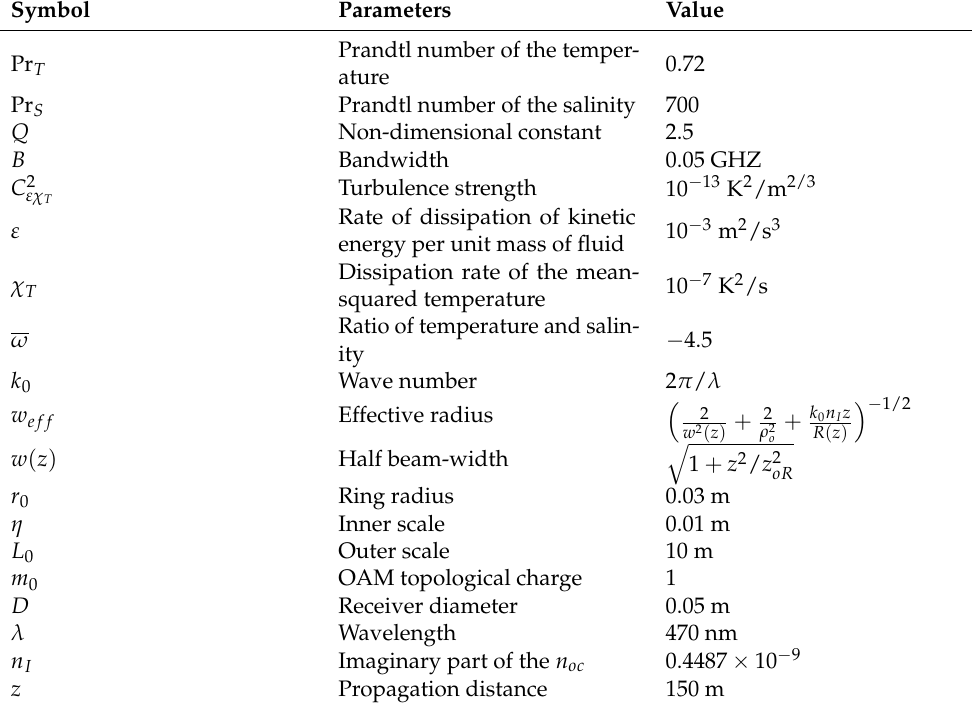
Table 1. Major system